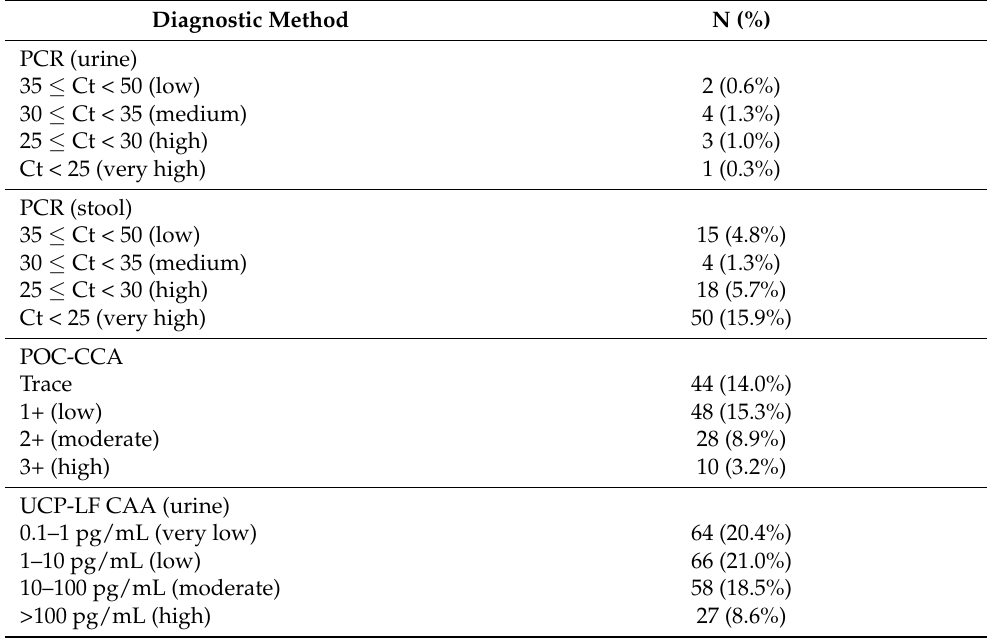
Table 1. The intensity of infection based on polymerase chain reaction (PCR) in urine and stool, point-of-care circulating cathodic antigen (POC-CCA), and the up-converting particle, lateral flow circulating anodic antigen (UCP-LF CAA) urine test in 314 individuals.